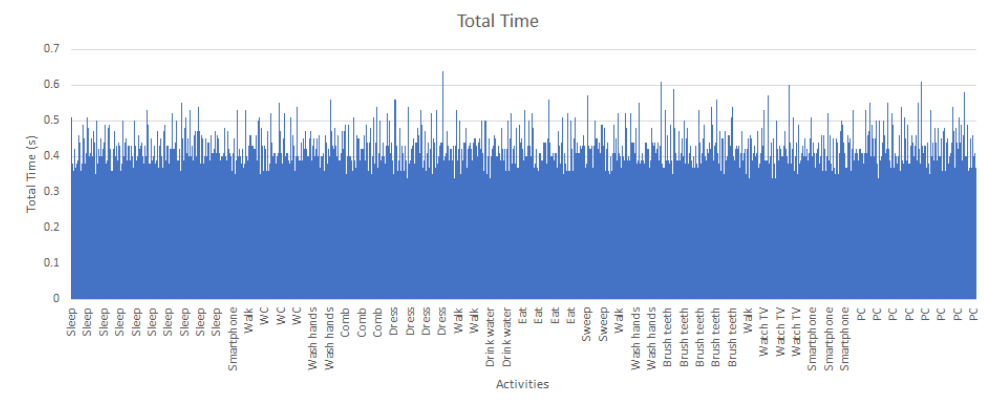
Figure 29. Total processing time of a sequence of activities.